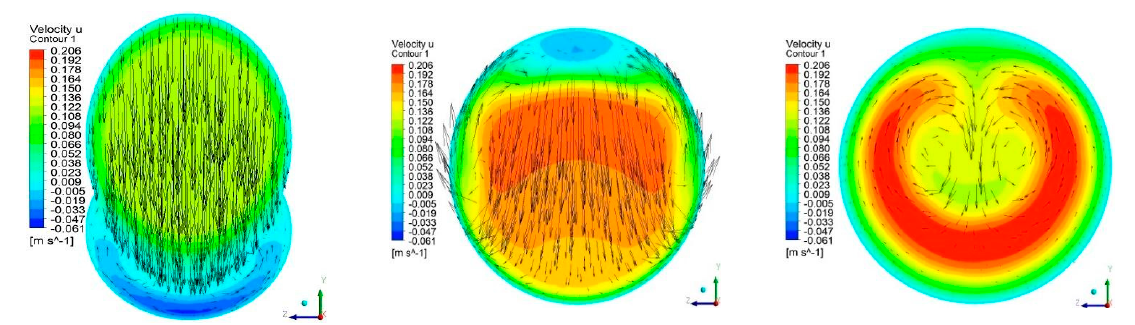
Figure 12. Streamwise velocity distribution in three cross sections with different stenosis/anastomo- sis flow rate ratios. flow rate